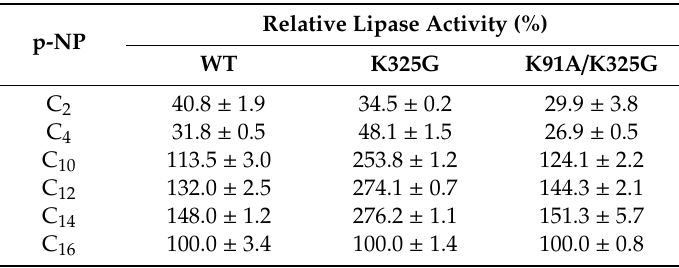
Table 2. Effect of substrates with various chain length on purified WT, K325G, and K91A / K325G lipase activity. p-NP